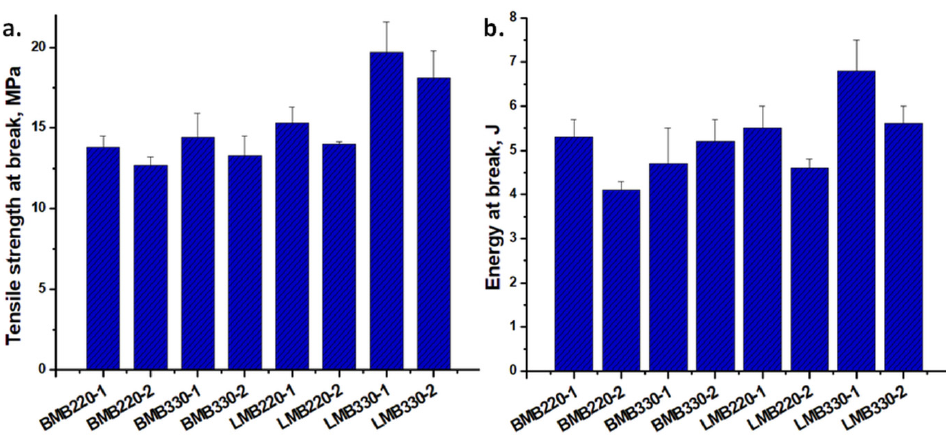
Figure 5. Tensile strength ( a ) and energy at break ( b ) for masterbatches processed in the Brabender or Leistritz extruders.